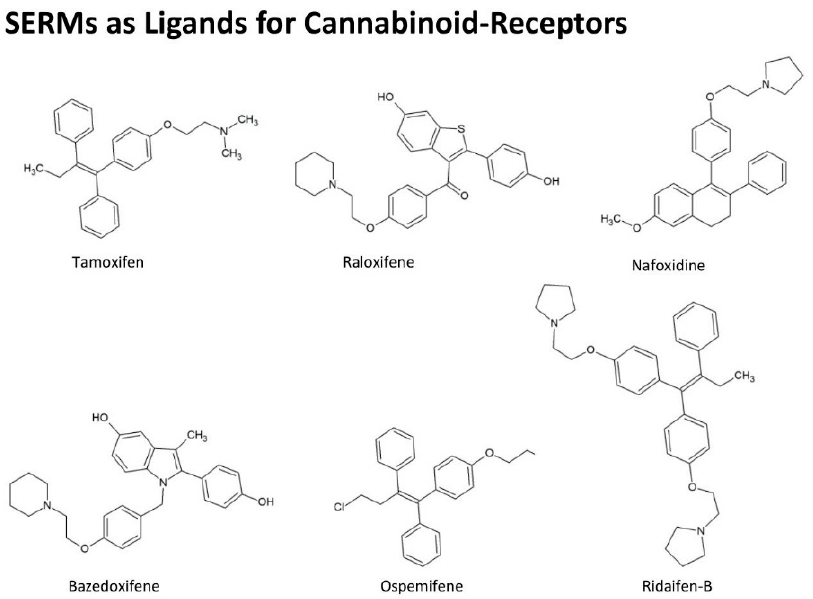
Figure 3. Chemical structures of SERMs. CBs: cannabinoids; SERMs: selective estrogen receptor modulators.